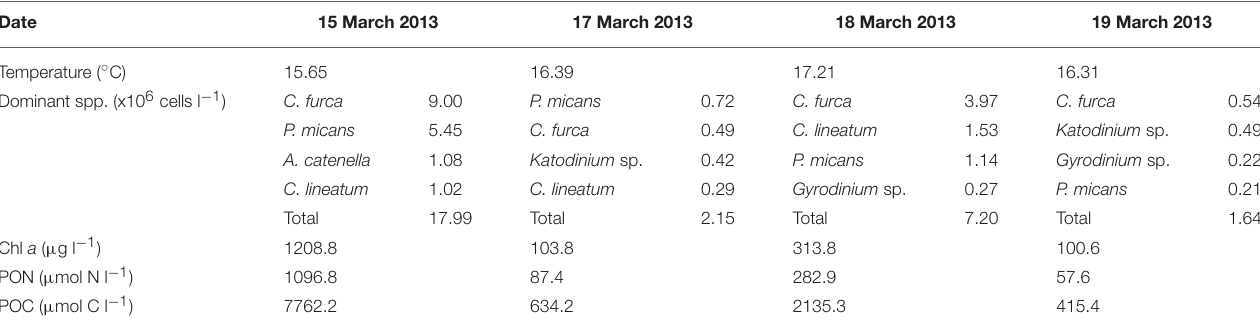
TABLE 1 | Date of surface water collection, surface water temperature, the dominant dinoflagellate species, and cell concentrations, and estimates of Chl- a , PON, and POC